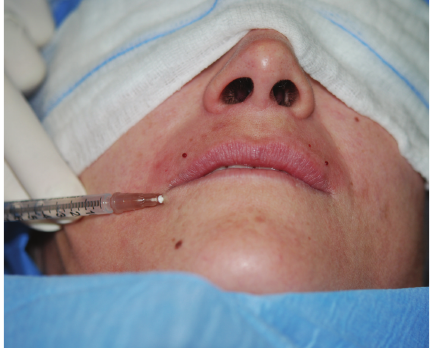
Figure 5: ADSCs injection.